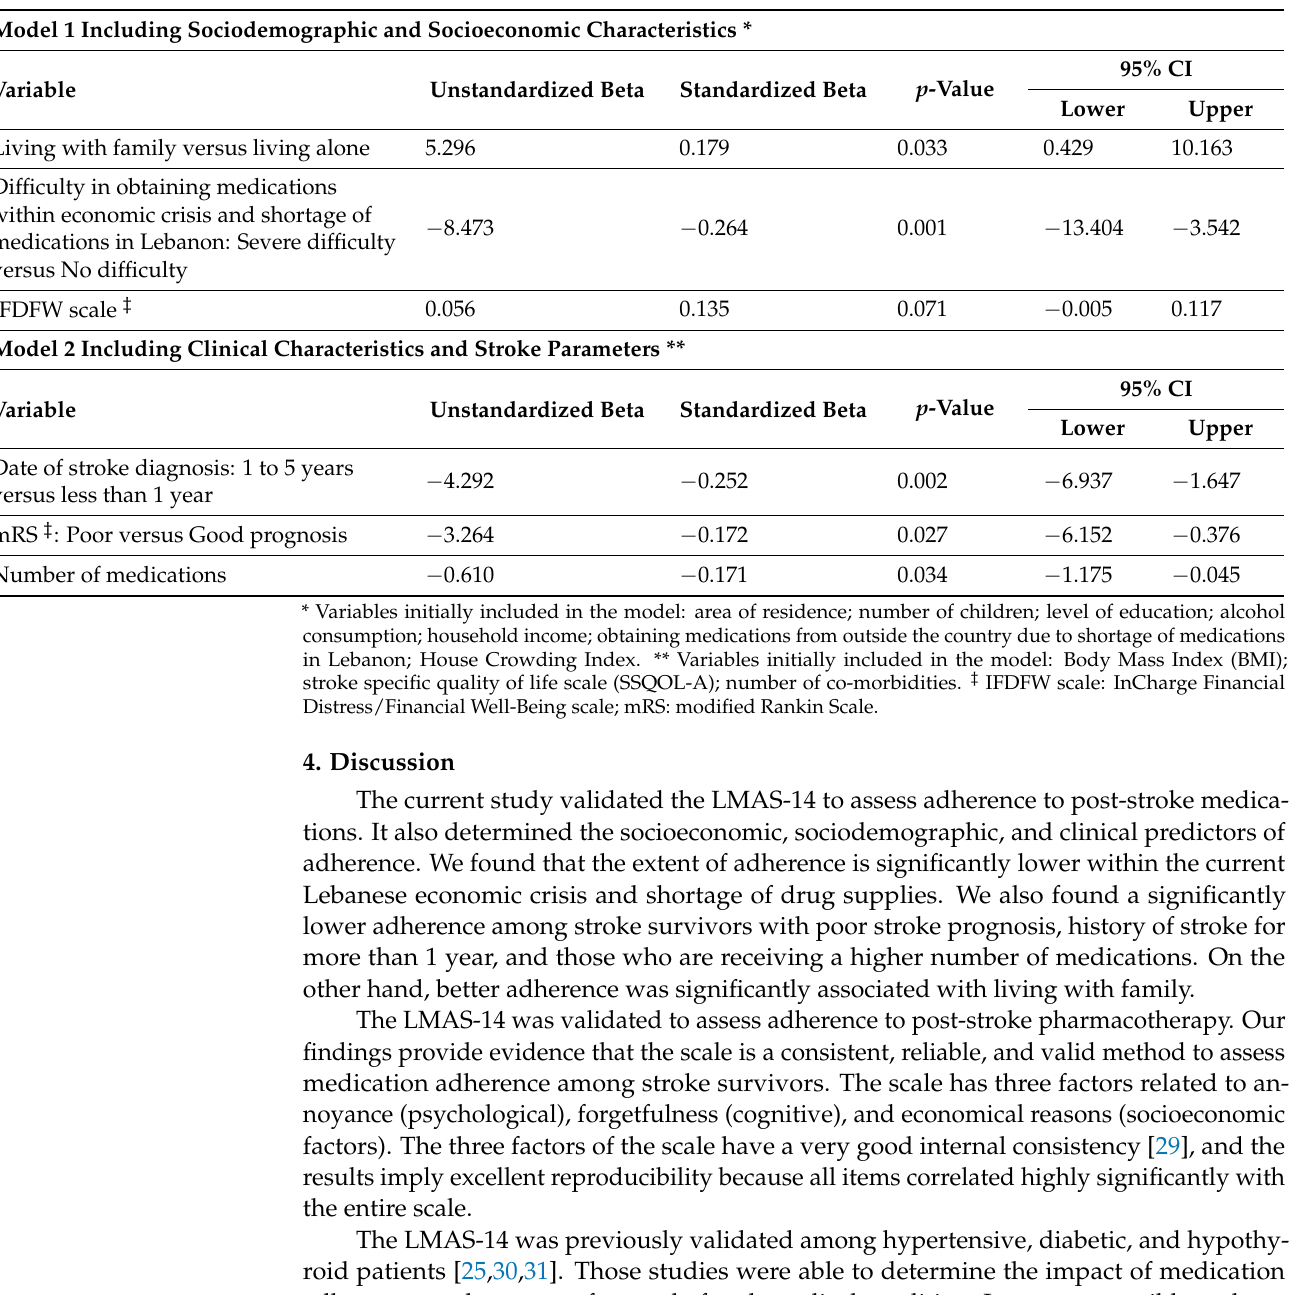
Table 7. Multivariable linear regression taking the LMAS-14 score as the dependent